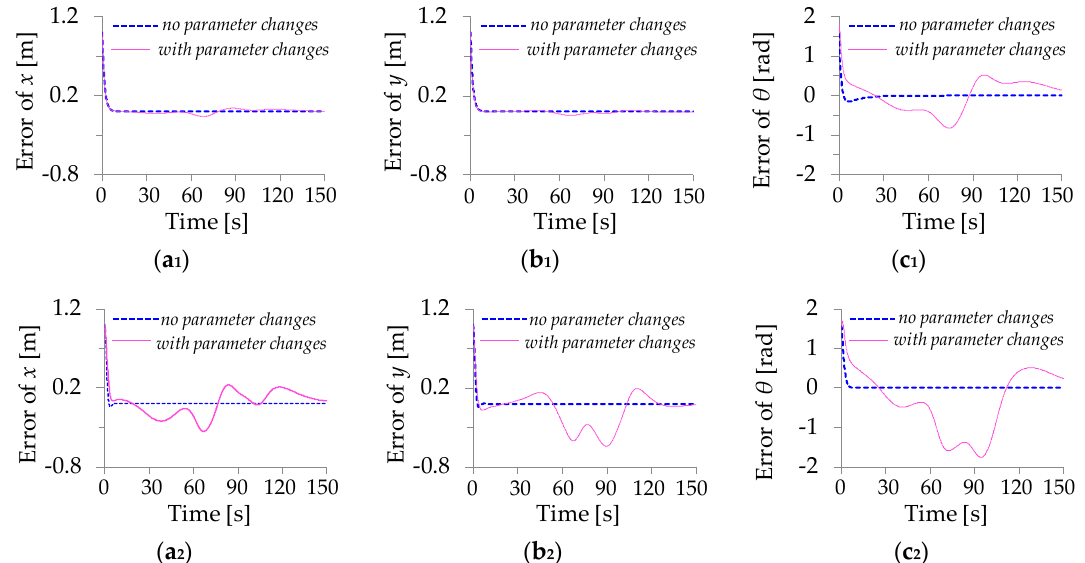
Figure 10. Trajectory and path tracking performance of non ‐ robust feedback tracking controller for the astroid path (primitive parameters m = 6 kg, r 0 = 0.2 m, α = π /2, R a = 0.56 Ω , and F friction = 0 : ( a 1 ) x position; ( b 1 ) y position; ( c 1 ) orientation θ ; and ( d 1 ) path tracking) (changed parameters m = 26 kg, r 0 = 0.3 m, α = π /3, R a = 0.76 Ω , and F friction = [0.2 N, 0.2 N, 0,3 N ∙ m]: ( a 2 ) x position; ( b 2 ) y position; ( c 2 ) orientation θ ; and ( d 2 ) path tracking).